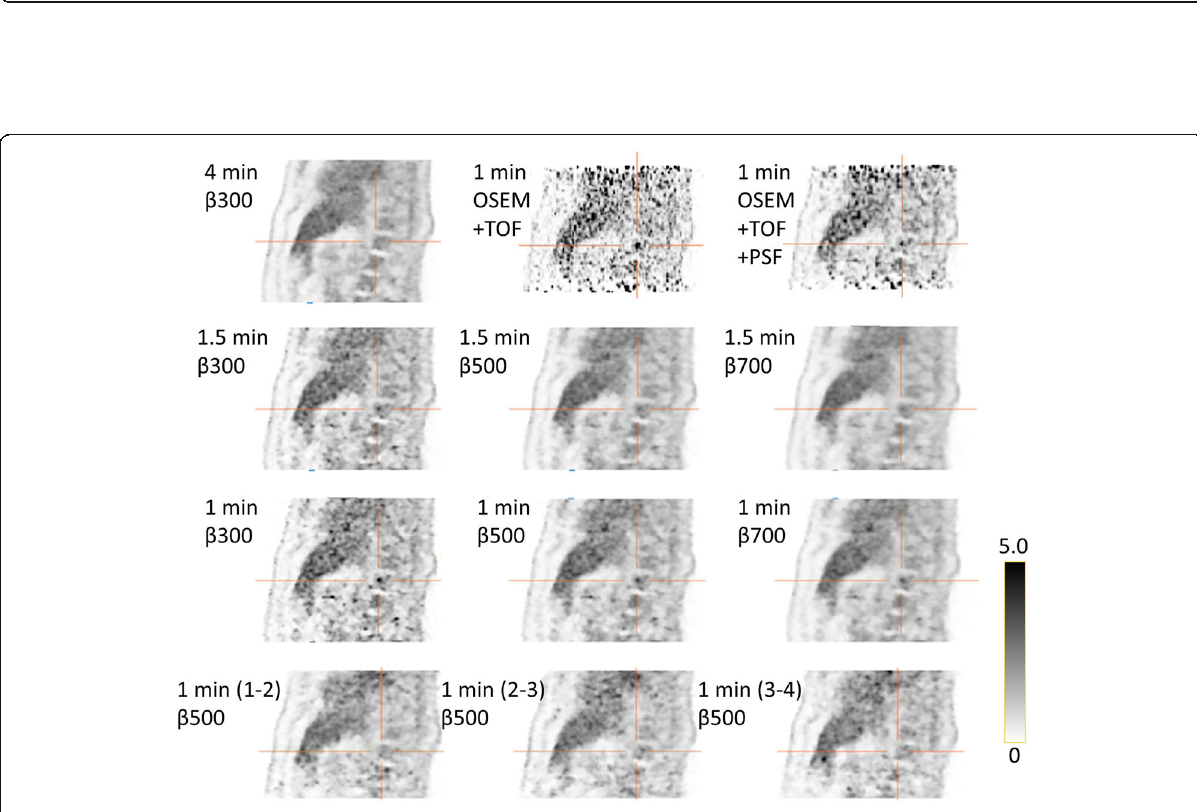
Fig. 5 Example of a lesion in a vertebra not visible in the 4-min reference (upper left corner) but, to different degrees, visible in the other combinations of time/bed position and β values evaluated. The last row shows 1-min reconstructions from the 4-min acquisition for the last 3 min, where the lesion is not visible. OSEM+TOF with and without PSF are shown in the upper